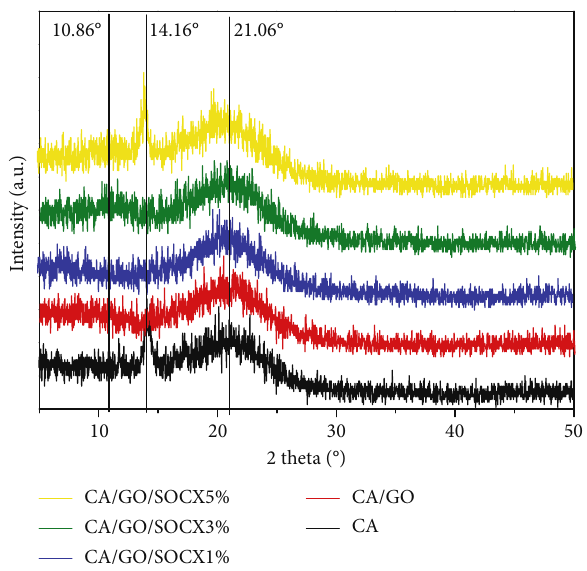
Figure 5: XRD di ff ractograms for nano fi bers of CA, CA/GO, and CA/GO functionalized with 1%, 3%, and 5% p -SOCX.